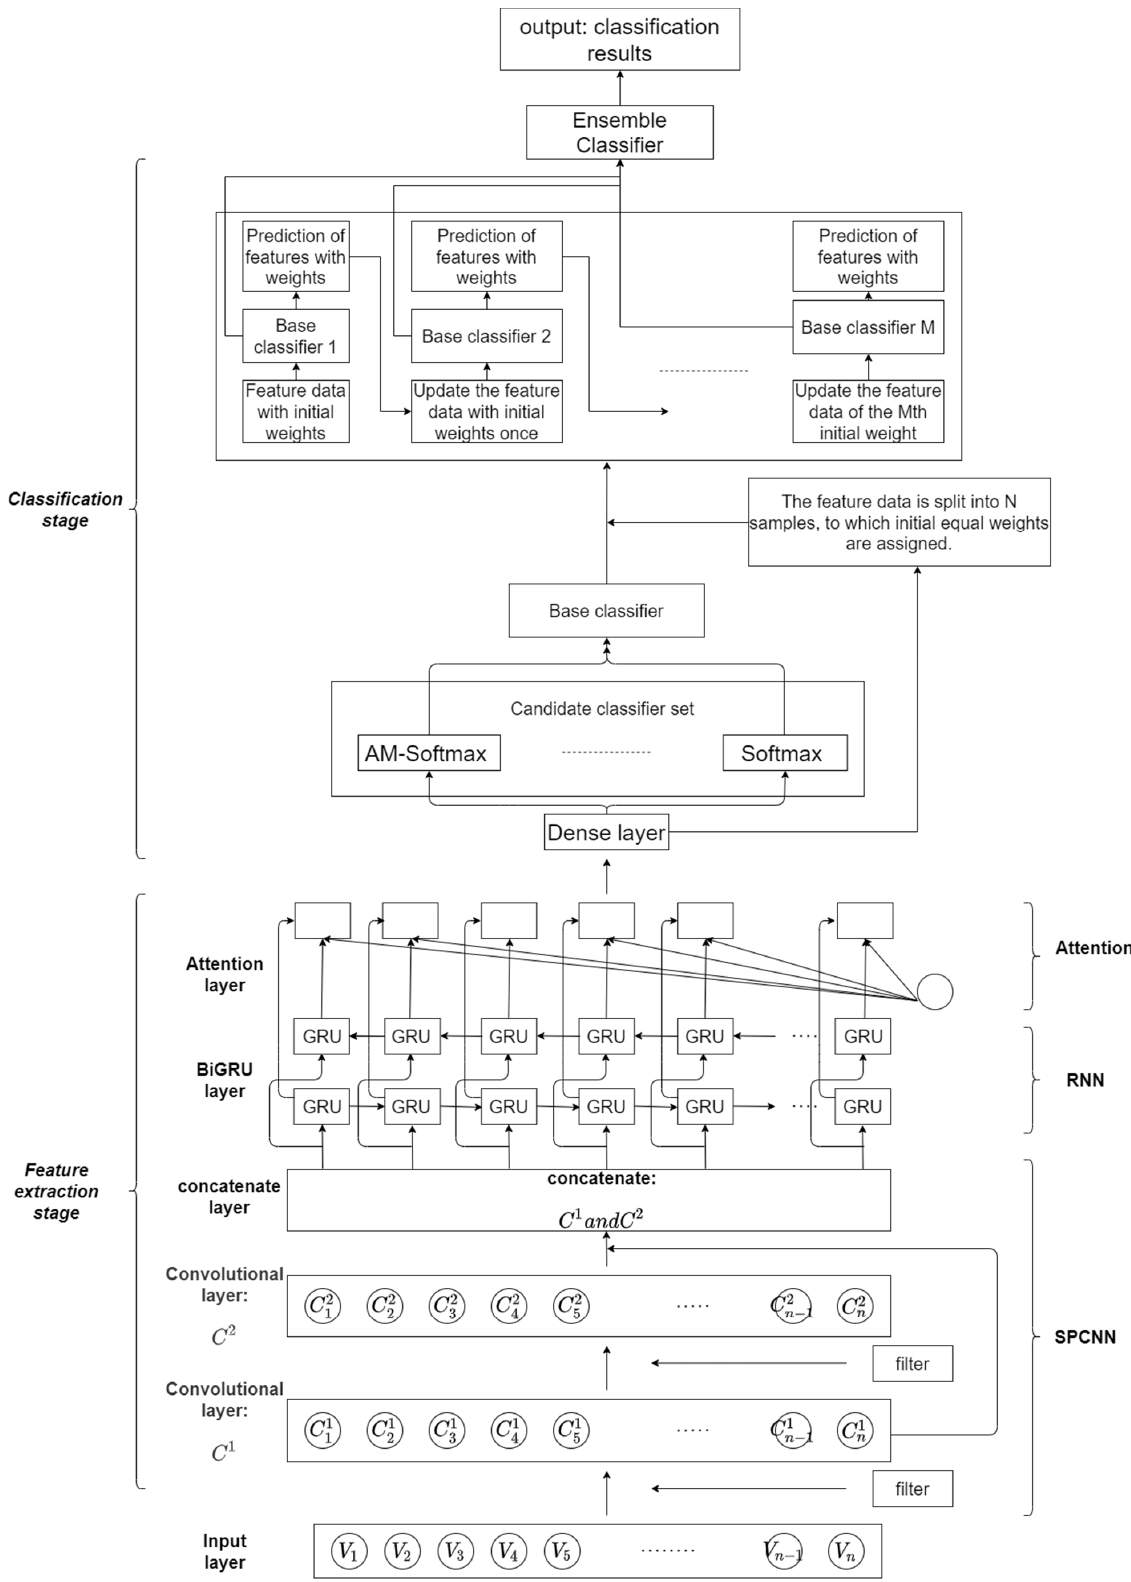
Figure 2. SPCBIG-EC. Figure 2.